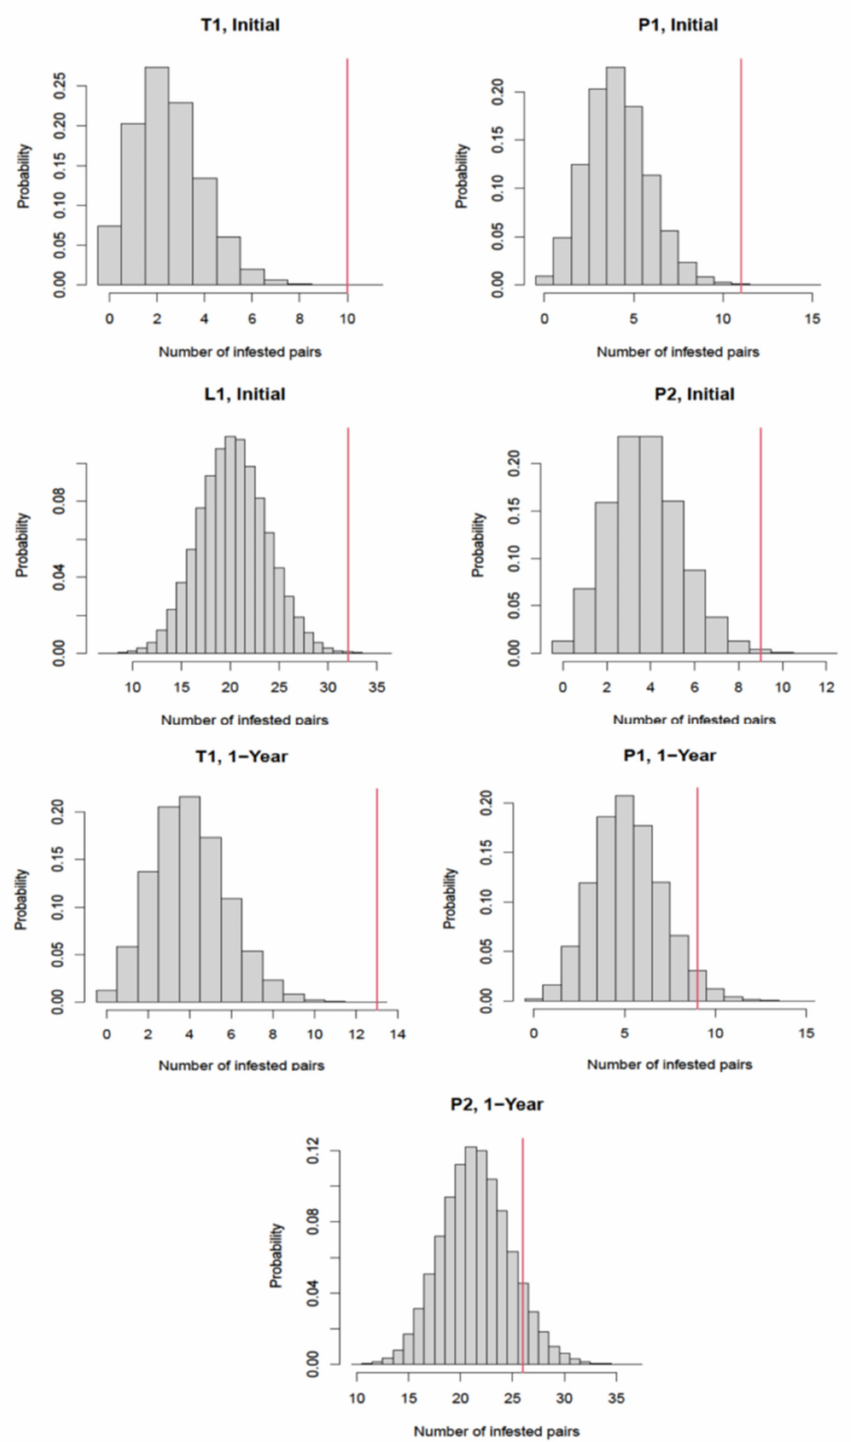
Figure 2. Distribution of the number of connected apartment pairs with both mouse infestation assuming no infestation correlation between two connected apartments in each building. The red vertical line indicates the actual number of infested connected apartment pairs in the